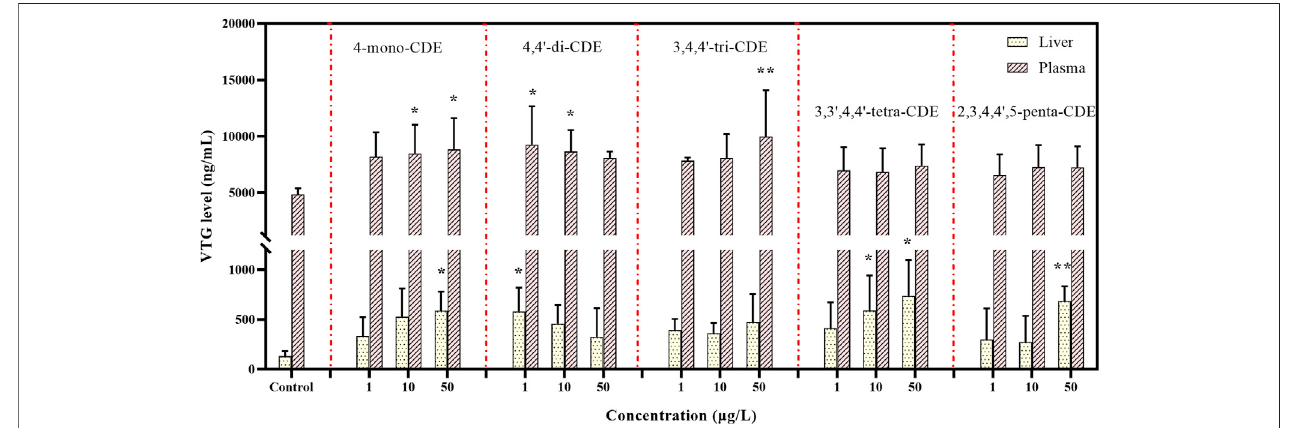
FIGURE 10 | Effect of PCDEs on VTG levels in liver homogenate and plasma of male zebra fi sh after 14 days of exposure.